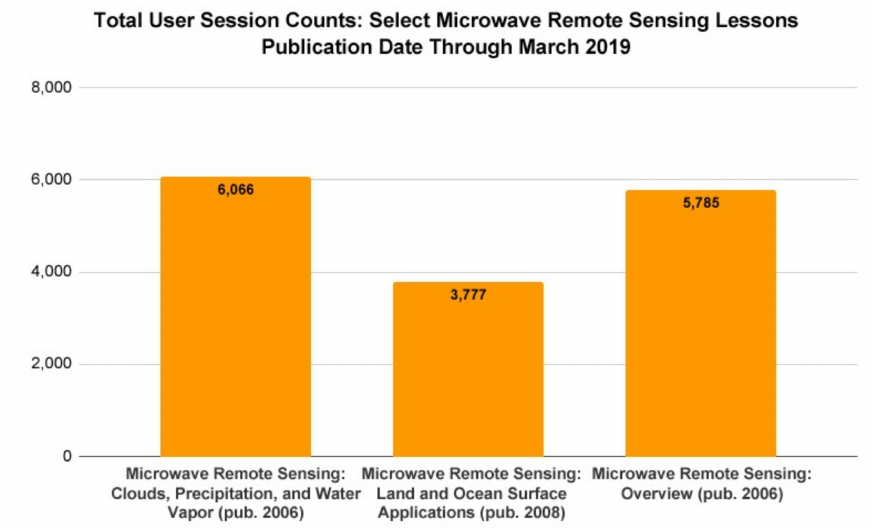
Figure 13. The bar chart shows total user session counts for select microwave remote sensing lessons from 2007 to the present (April 2019). A session is defined as a learner accessing more than one page in